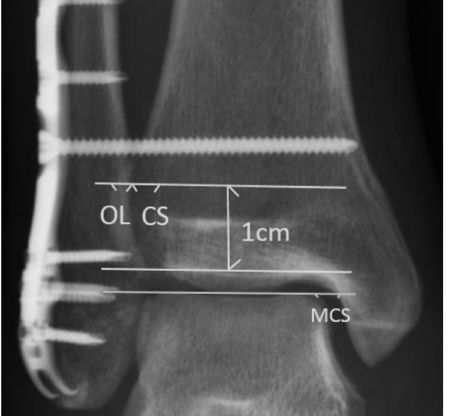
Figure 1. Radiographic evaluation in the study. The tibiofibular clear space (CS) was defined as the distance between the lateral border of the posterior tibial malleolus and the medial aspect of the fibula, measured 1 cm proximal to the tibial plafond. The medial clear space (MCS) was defined as the distance from the lateral border of the medial malleolus to the medial border of the talus at the level of the talar dome. The tibiofibular overlap (OL) was measured from the lateral border of the anterior tibial prominence to the medial fibula 1 cm proximal to the tibial